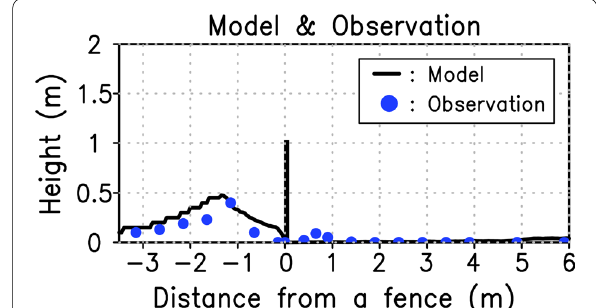
Fig. 14 Snowdrift profile around the two-dimensional fence in the cross section along y 2.5 m (line) (as shown in Fig. 8a) and the = snowdrift profile observed in Okaze et al. (2019) (blue